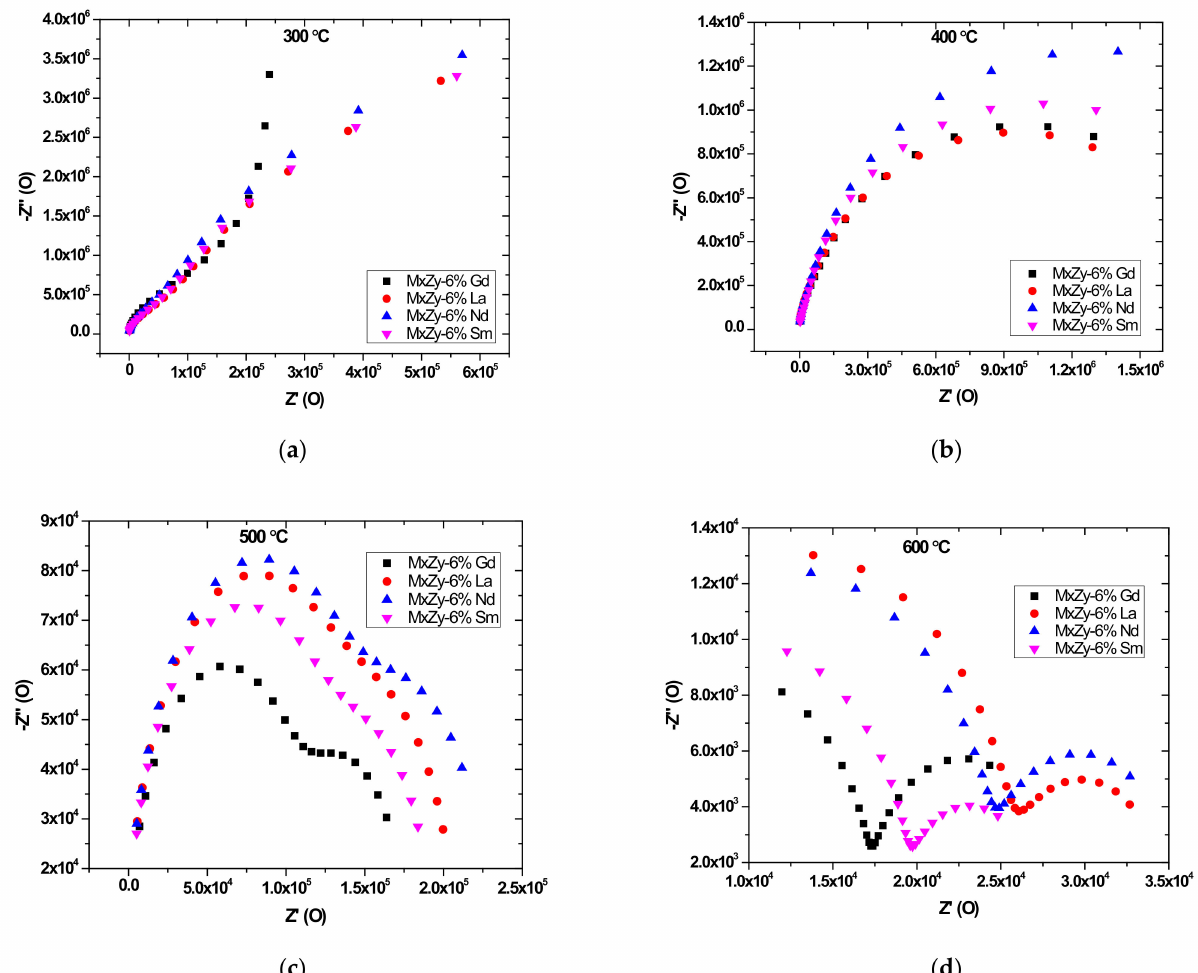
Figure 7. ( a ) Nyquist plots for samples ZrO 2 co-doped with 8 wt.% Y 2 O 3 and 6 wt.% Ln 2 O 3 at 300 ◦ C; ( b ) Nyquist plots for samples ZrO 2 co-doped with 8 wt.% Y 2 O 3 and 6 wt.% Ln 2 O 3 at 400 ◦ C; ( c ) Nyquist plots for samples ZrO 2 co-doped with 8 wt.% Y 2 O 3 and 6 wt.% Ln 2 O 3 at 500 ◦ C; and ( d ) Nyquist plots for samples ZrO 2 co-doped with 8 wt.% Y 2 O 3 and 6 wt.% Ln 2 O 3 at 600 ◦ C.